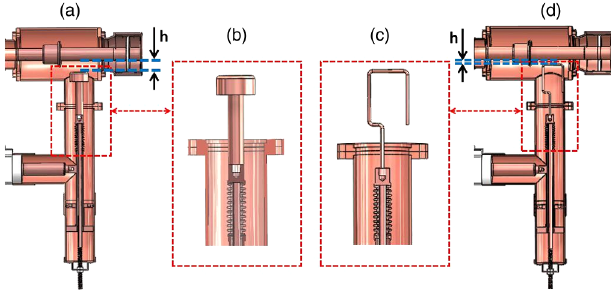
FIG. 6. The mechanical drawings of the secondary coupler. (a) shows the coupler with electric probe; (b) depicts the enlarged view of the electric probe; (c) is the enlarged view of the magnetic loop; and (d) shows the coupler with magnetic